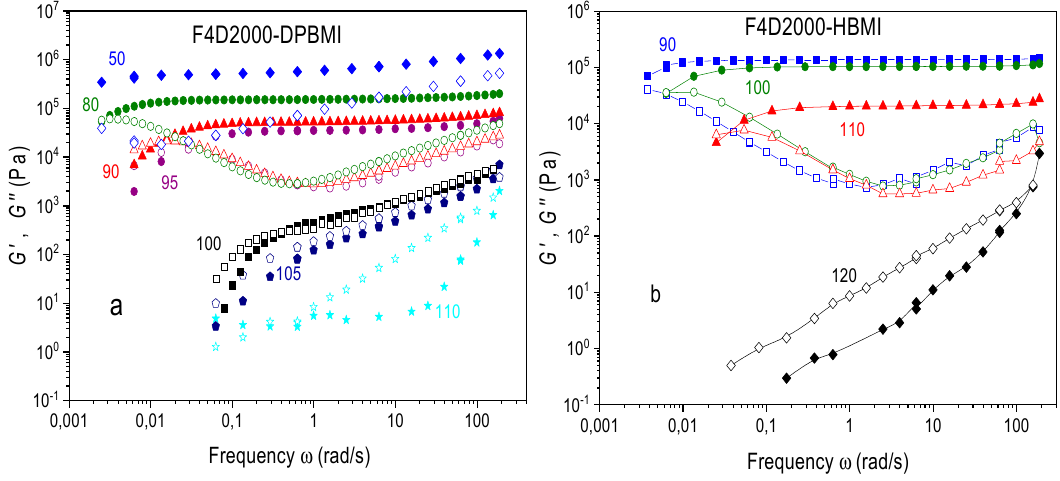
Figure 11. Shear moduli G’ ( ● ) and G“ ( ○ ) of the DA networks at different temperatures as functions of frequency; temperatures are indicated.